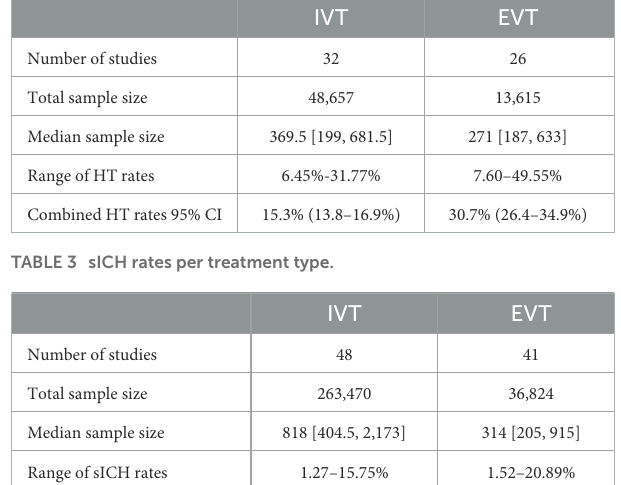
TABLE 2 Any ICH rates per treatment type.